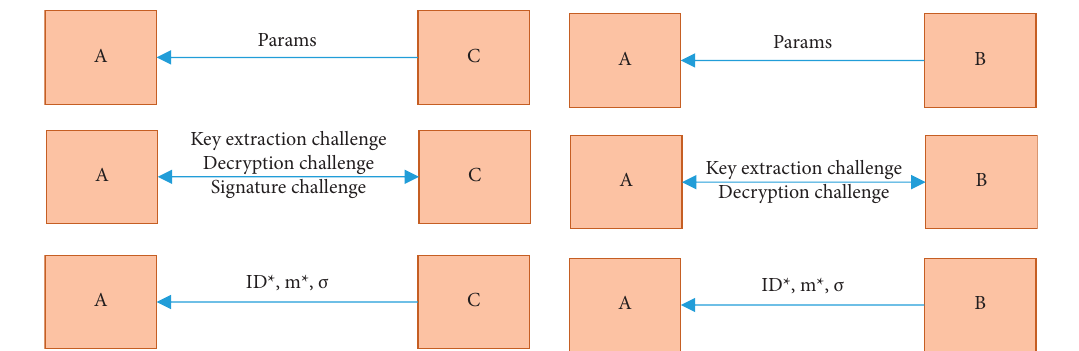
Figure 9: IBCES signature scheme